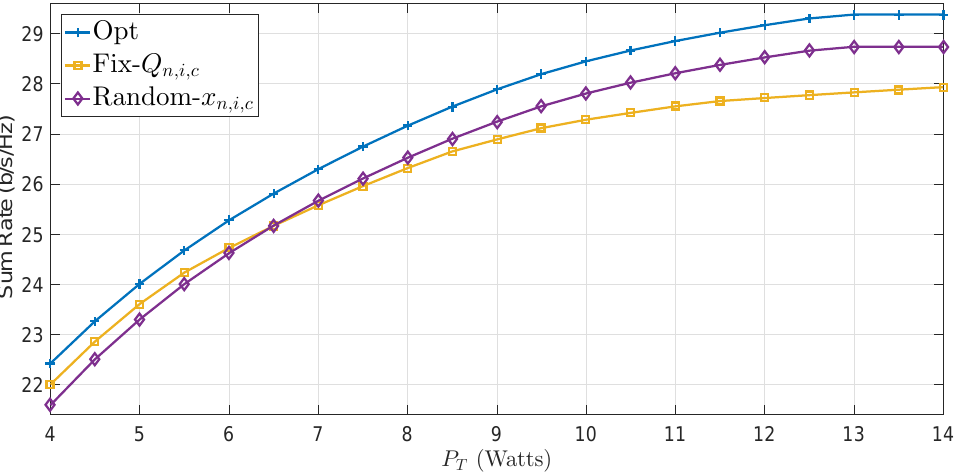
Figure 2. Impact of P T on sum rate for 3 different